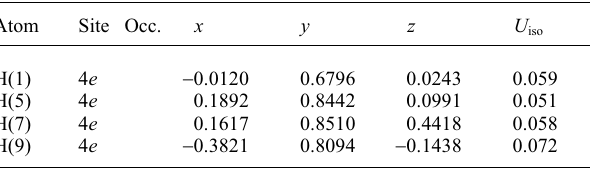
Table 2. Atomic coordinates and displacement parameters (in Å 2 )